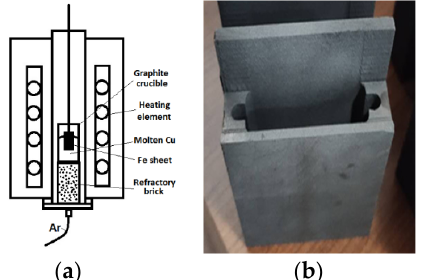
Figure 1. Experimental equipment: ( a ) device of casting compound experiment and ( b ) the casting mold.